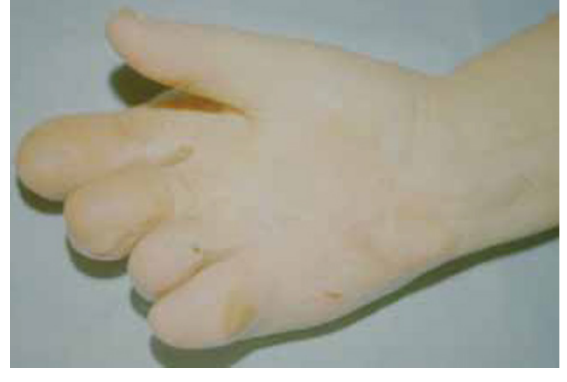
Figure 5. Clinical case 2. The tissue defect was covered with the omental free fl ap and a spulit-thickness skin